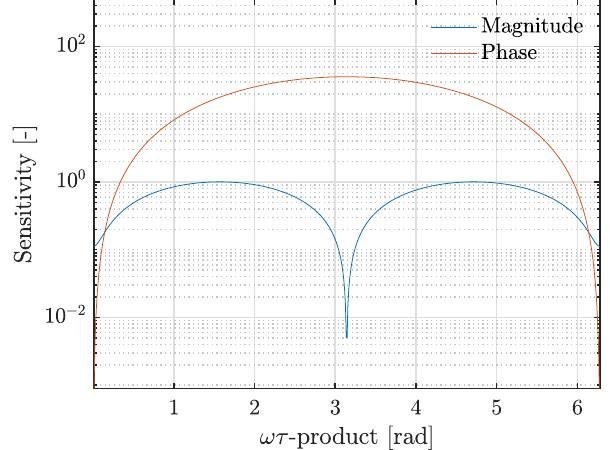
Figure 12. Sensitivity of the lubrication film thickness with regard to the magnitude and phase of the reflection coefficient spectrum, as a function of the ωτ -product.